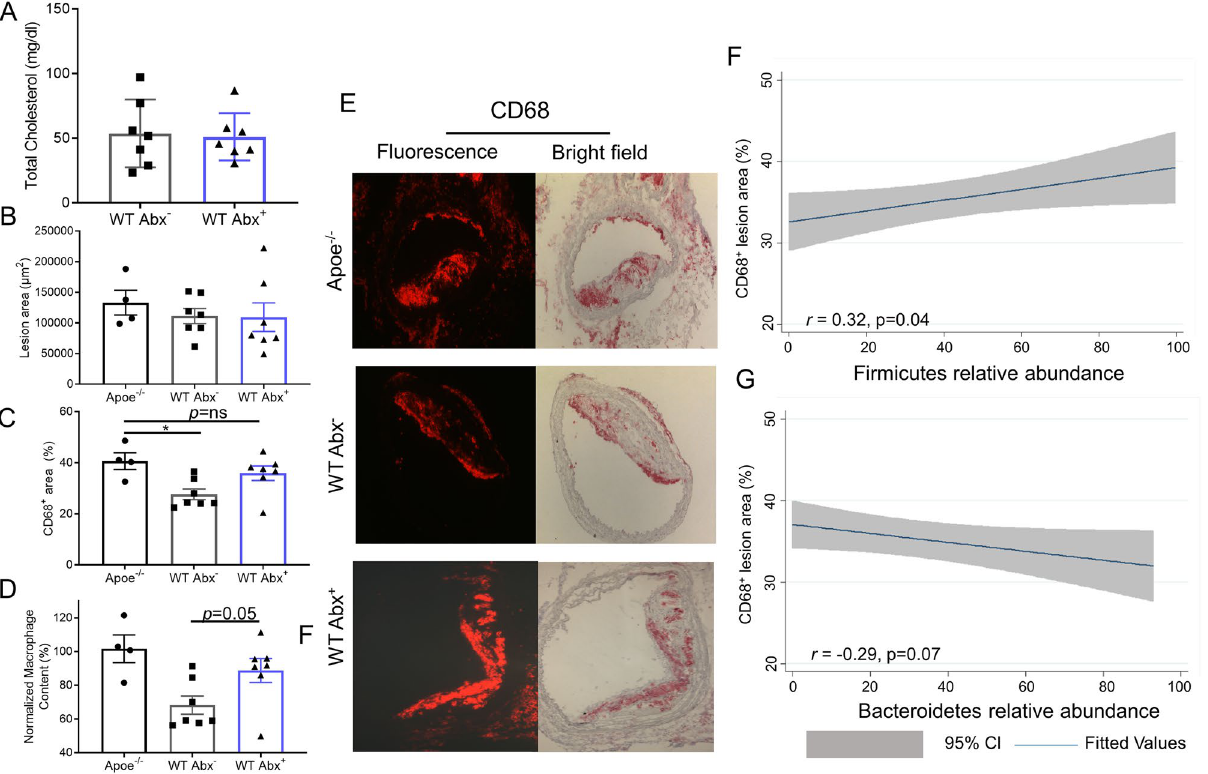
Figure 2. Antibiotic exposure impairs atherosclerotic plaque inflammation resolution. Analysis of aortic arch plaques from Apoe −/− mice after 16 weeks on a Western Diet in WT-recipient mice 5-days post-transplant. Quantification of ( A ) Total cholesterol, ( B ) Lesion area, ( C ) percent CD68 + area within plaque, ( D ) CD68 + area normalized with respect to the Apoe −/− donor mice. ( E ) Representative sections of aortic transplant arches from Apoe −/− , WT-post-Abx + and WT-post-Abx − groups, stained with anti-CD68 antibody at ×100 magnification, with bright field images shown for full morphology. Relation of CD68 + lesion areas with relative ( F ) Firmicutes and ( G ) Bacteroidetes taxa abundances of fecal samples taken at the experiment end. Mann–Whitney and Pearson’s correlation test used. (n = 4–7 mice/group) * <